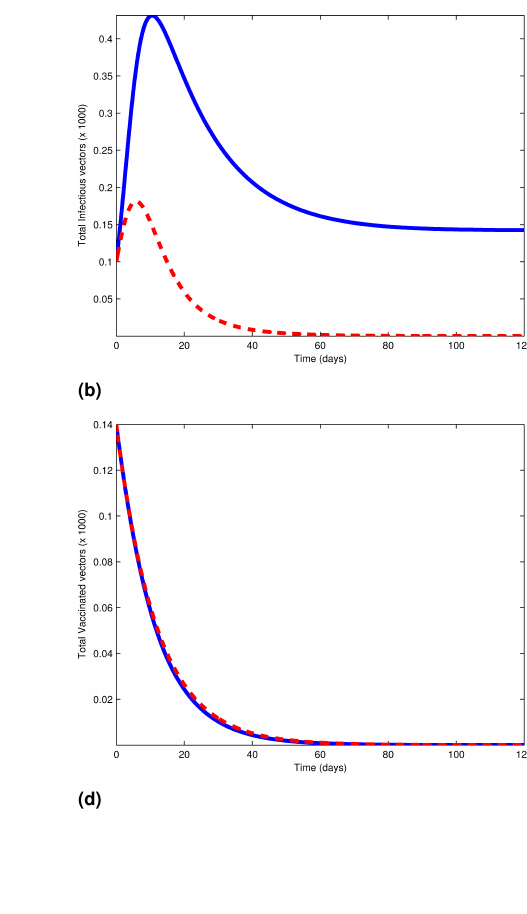
Fig. 6. Simulations of the leptospirosis model showing the effect of the optimal strategies: Treatment of humans and treatment of infectives vectors. The blue lines represent the cases without control, while the red lines indicate the cases with optimal